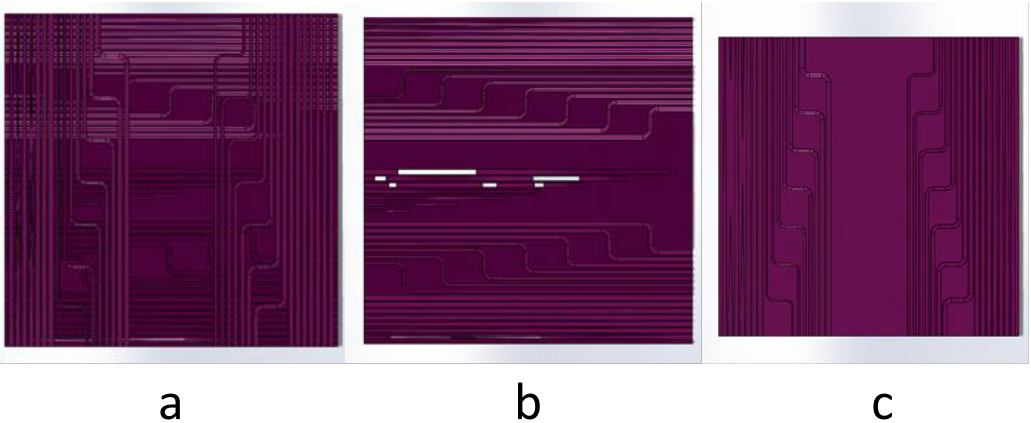
Figure 2. Whole design, the first part of the specimen, and the second part of the specimen shown in ( a – c ) separately.